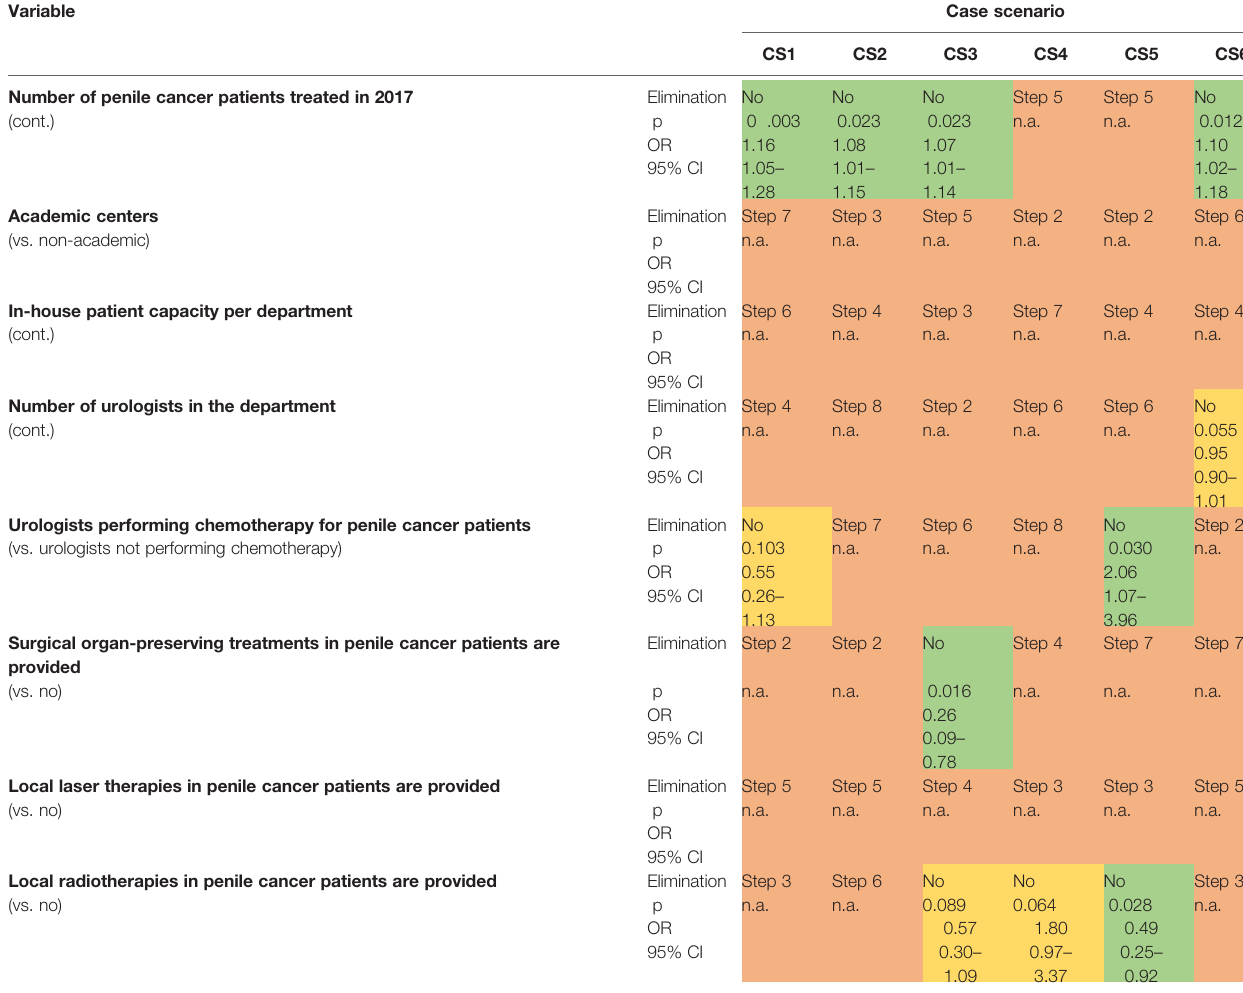
TABLE 3 | Summary of the regression models on the in fl uence of the annual caseload and other predictor variables on the probability of guideline-adherent treatment recommendations in the queried case scenarios.